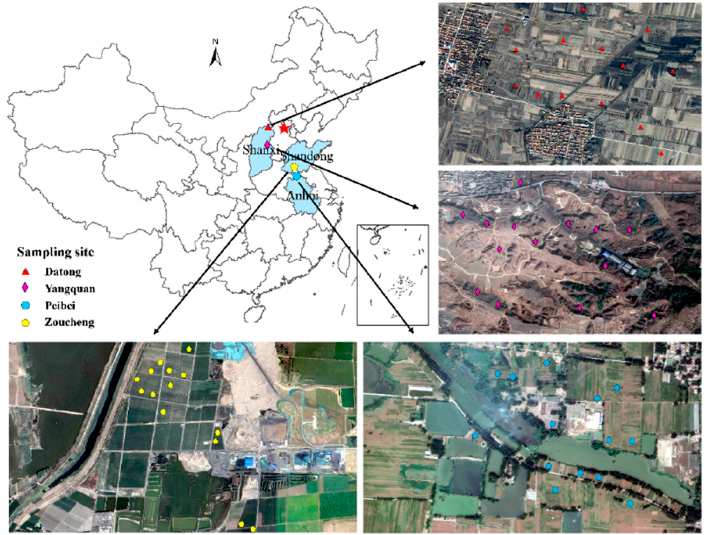
Figure 1. Location of the study area.